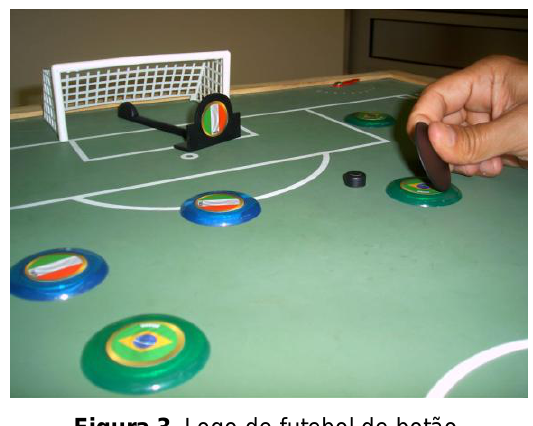
Figura 3. Jogo de futebol de